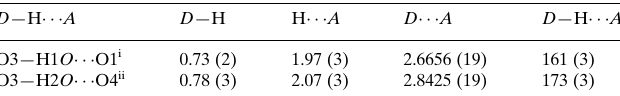
Hydrogen-bond geometry (A˚ , (cid:3)